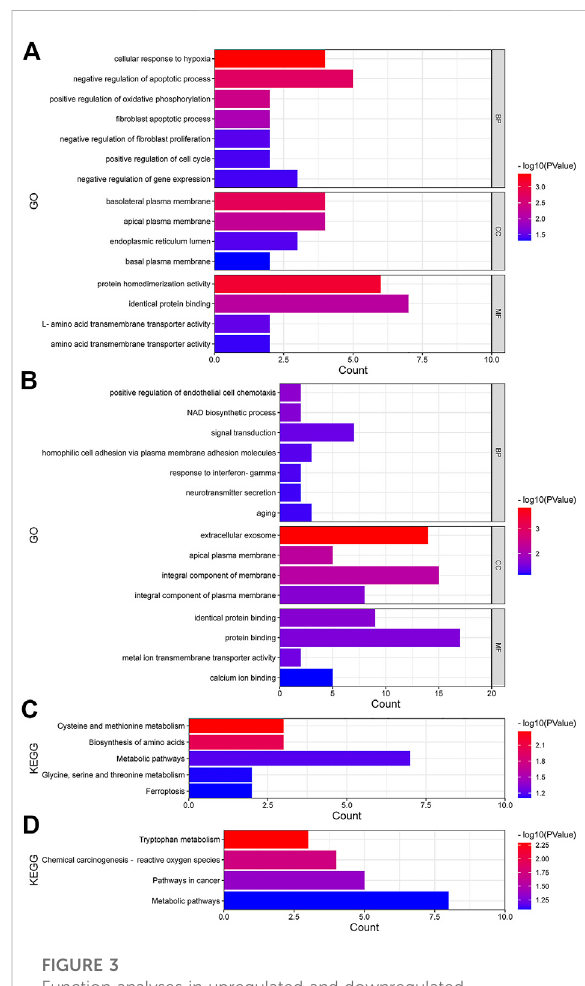
FIGURE 3 Function analyses in upregulated and downregulated DEmRNAs. (A , B) GO analysis of upregulated and downregulated DEmRNAs. (C , D) KEGG pathway analysis of upregulated and downregulated DEmRNAs. BP, biological processes; CC, cellular components; MF, molecular